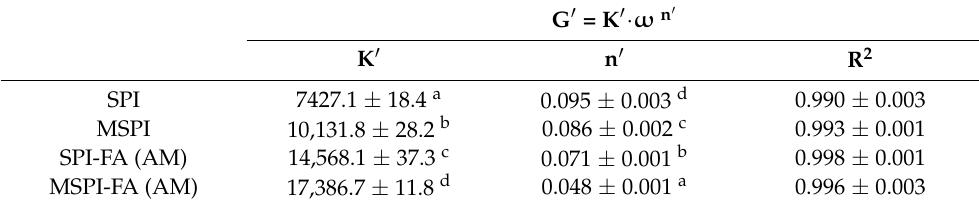
Table 4. Frequency dependence parameters of different emulsion gels